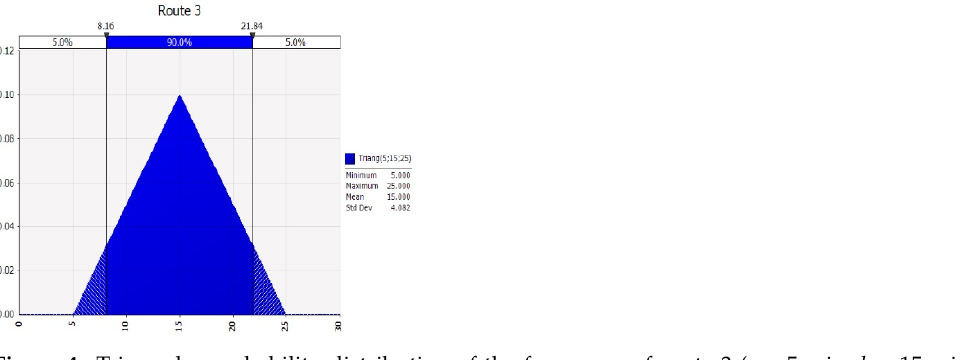
Figure 4 Figure 4. Triangular probability distribution of the frequency of route 3 ( a = 5 min; b = 15 min; c = 25